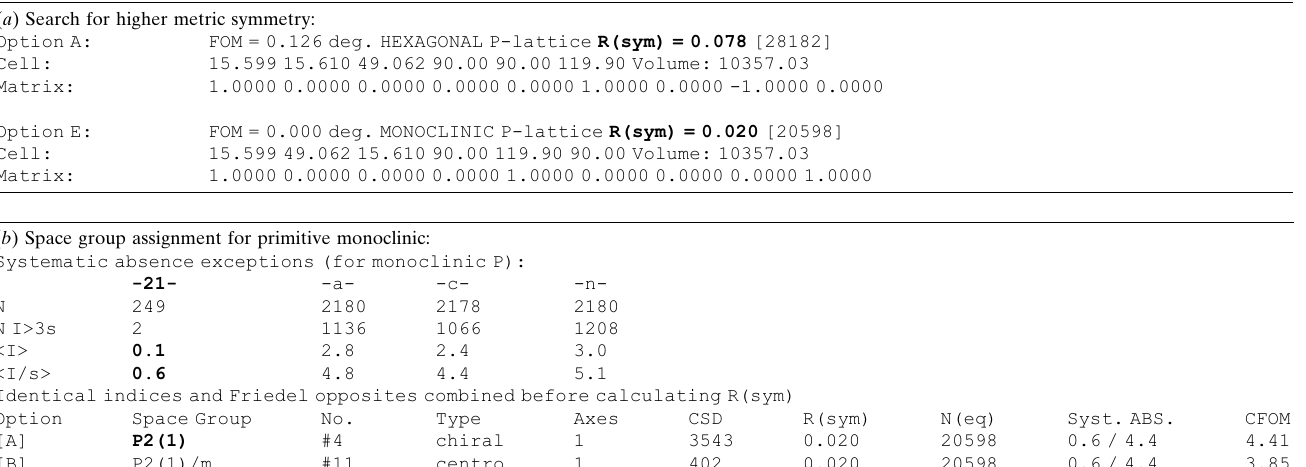
Table 2 Selected annotated output from XPREP for WUGLES. ( a ) The unit-cell parameters suggest the hexagonal crystal system, but R sym for primitive monoclinic is much better (various C -centred orthorhombic and monoclinic cells all had R sym ’ 30% and are not shown). ( b ) Systematic absences indicate only a 2 1 screw